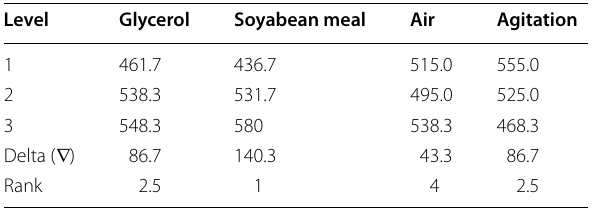
Table 6 Response Table for Means of Setomimycin production by Streptomyces sp. RA-WS2